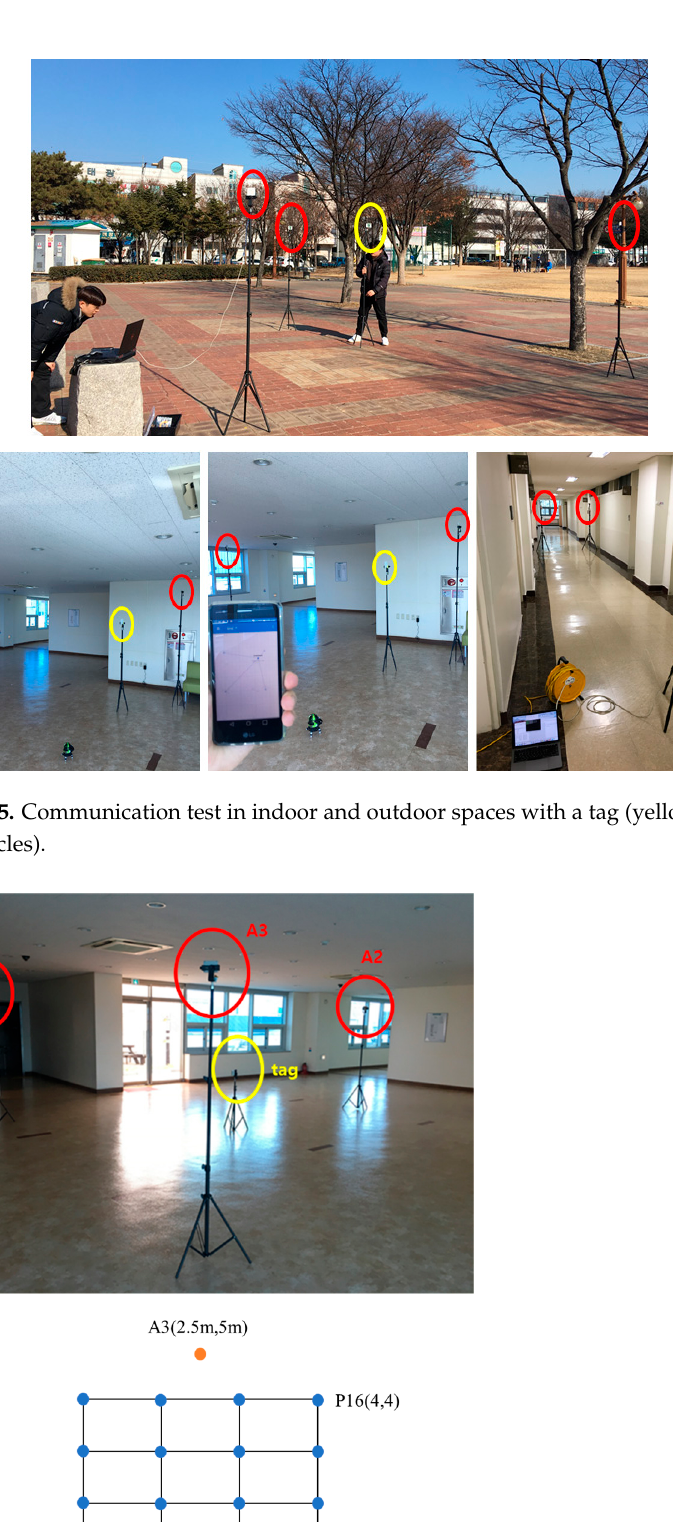
Figure 6. LOS environment test for measuring the coordinates of 16 fixed positions for a tag (yellow circle) based on 3 anchors (red circle; A1, A2, A3) installed in an indoor space without obstacle. Table 1. Indoor LOS and NLOS measurement data.